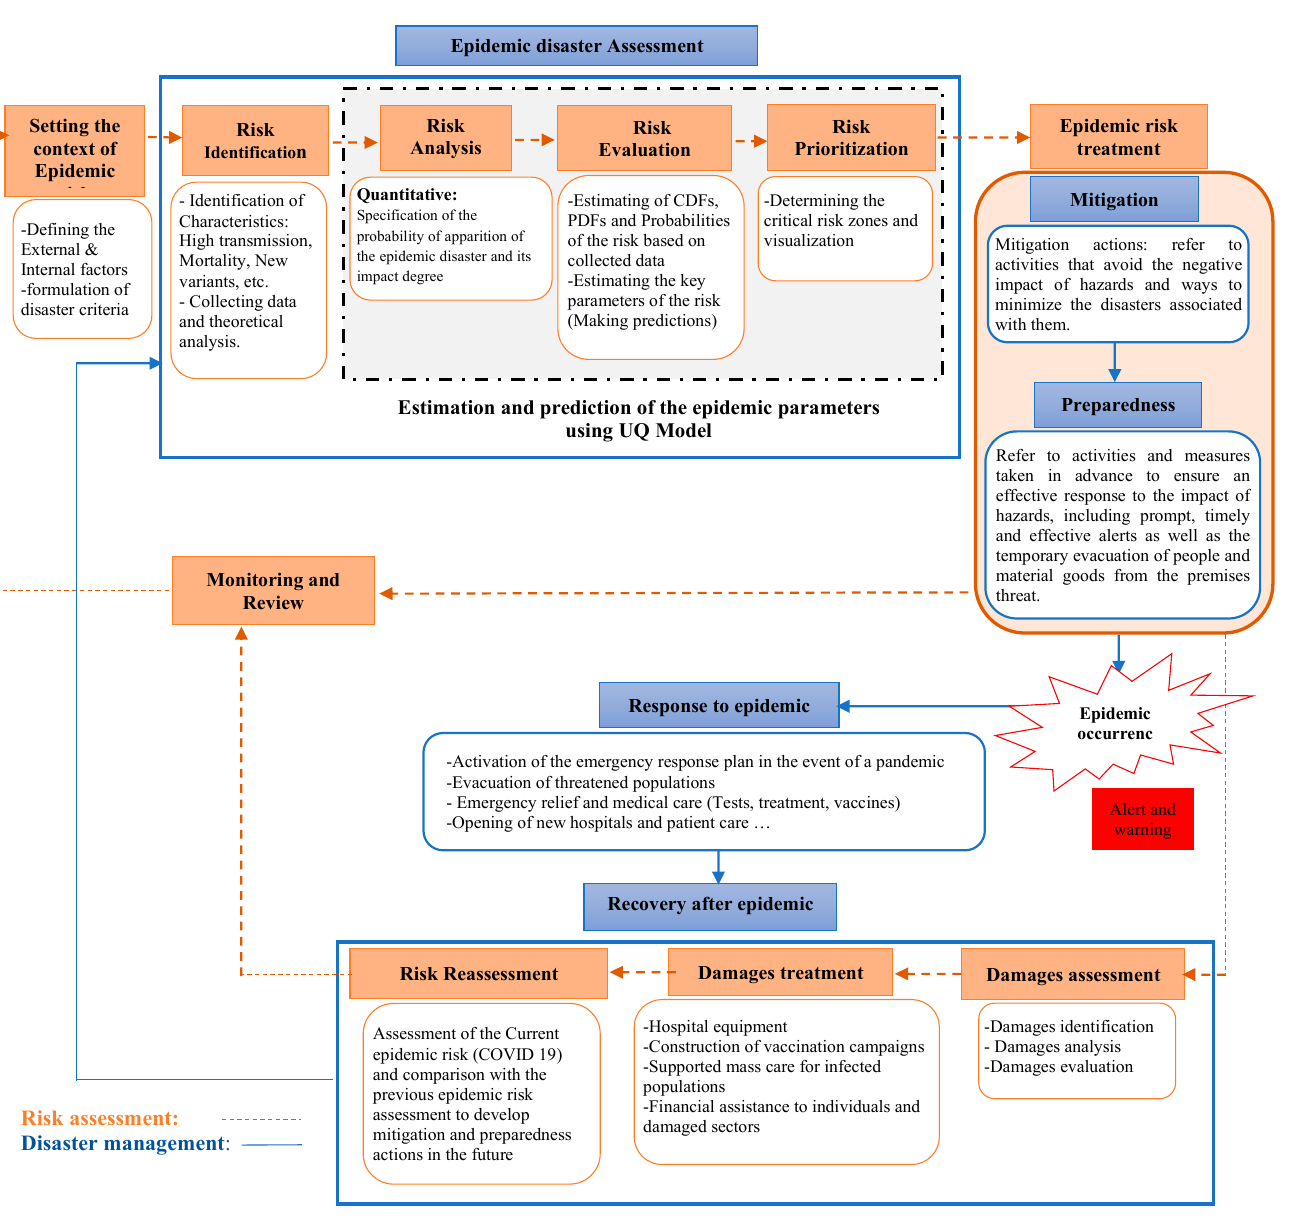
Figure 22. Epidemic risk management approach based on uncertainty quantification model. Estimation of epidemic parameters can be performed by collocation and/or moment matching method. Taking a decision at the right time during each phase leads to better preparation, better alerts, reduced vulnerability and/or prevention of future disasters. The cycle in orange as seen in the framework represents the risk management process while the blue one represents the correspondence between the stages of risk management and those of the disaster management